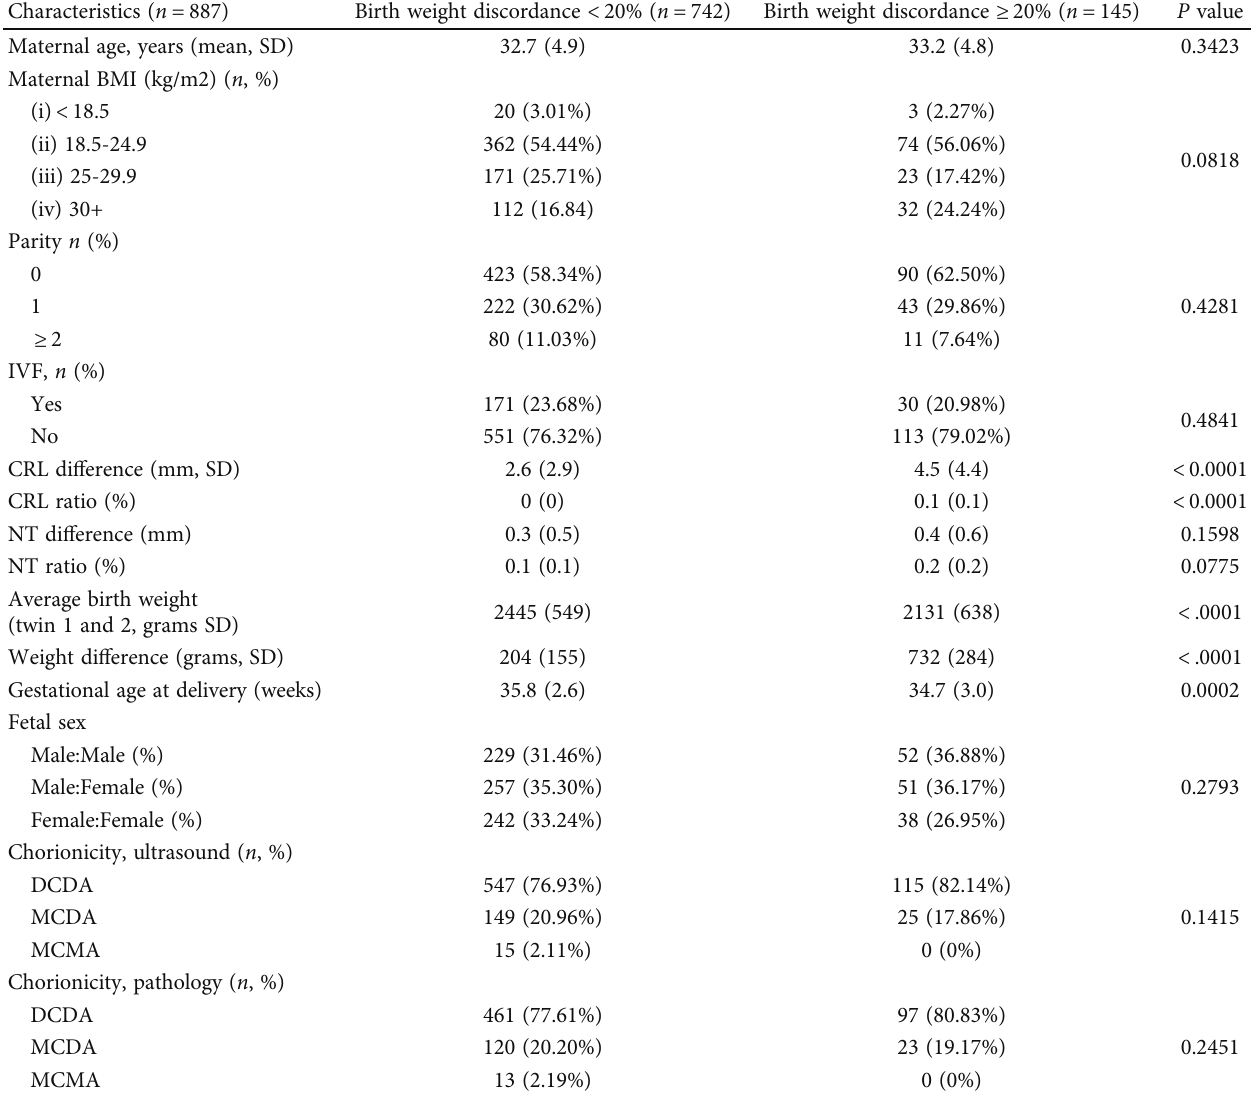
Table 1: Subject characteristics in twins with a birth weight discordance < 20% vs. ≥